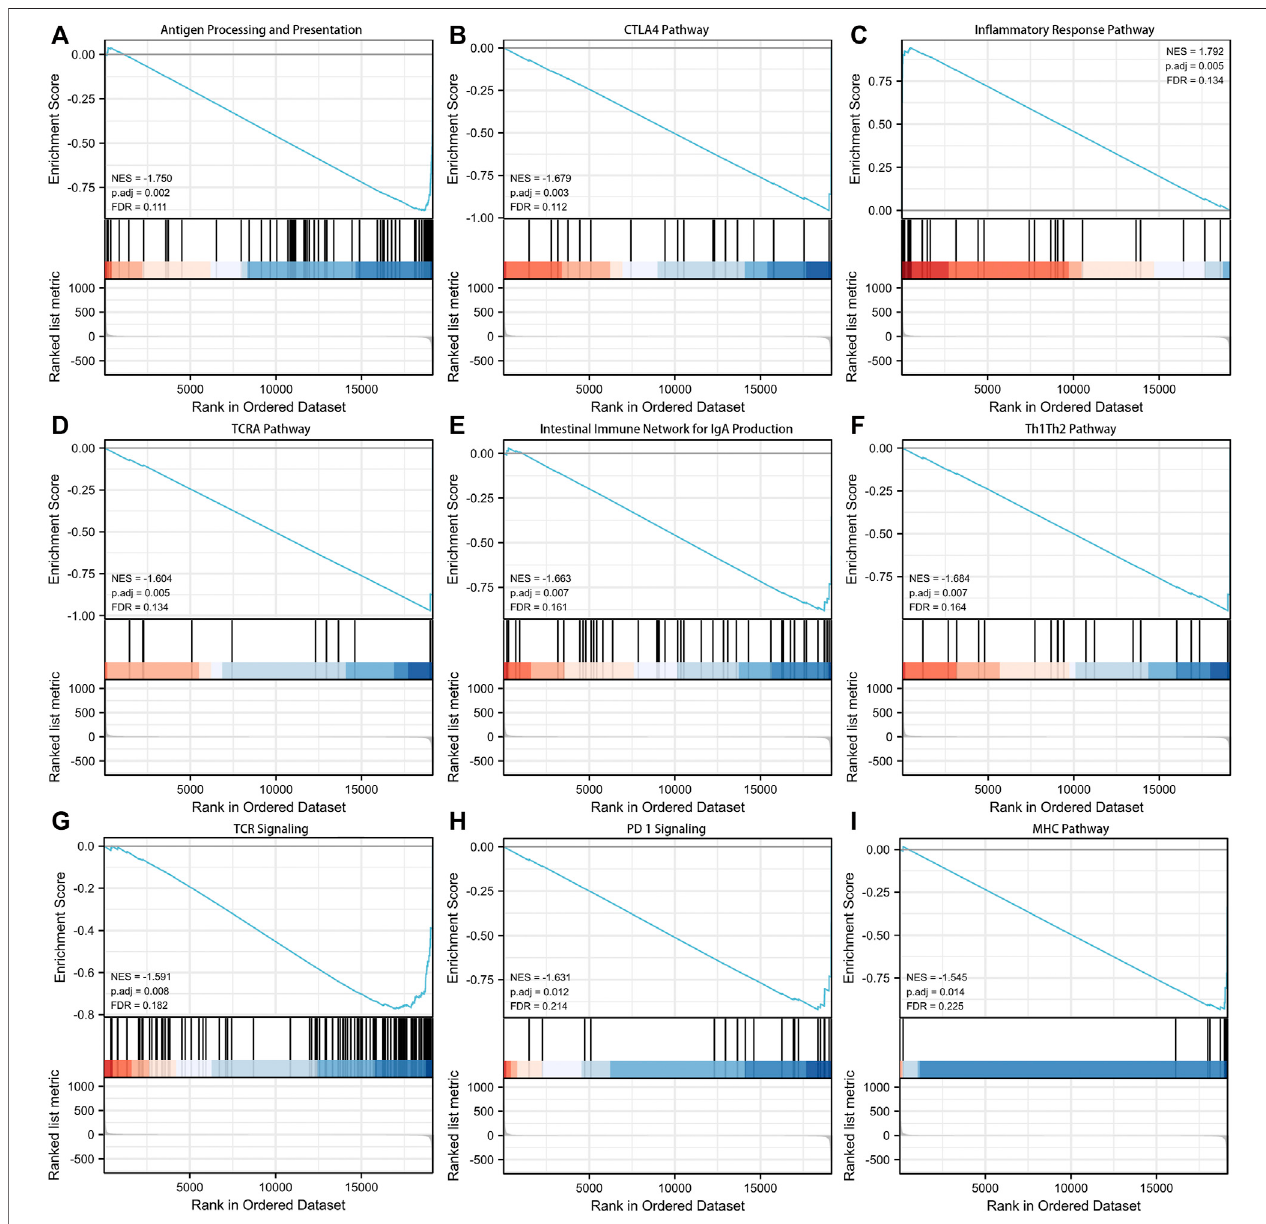
FIGURE 5| Gene set enrichment analysis (GSEA) about the exosomes-related lncRNA prognostic signature. (A) Antigen processing and presentation. (B) CTLA4 pathway. (C) In fl ammatory response pathway. (D) TCRA pathway. (E) Intestinal immune network for IgA production. (F) Th1Th2 pathway. (G) TCR signaling. (H) PD-1 signaling. (I) MHC